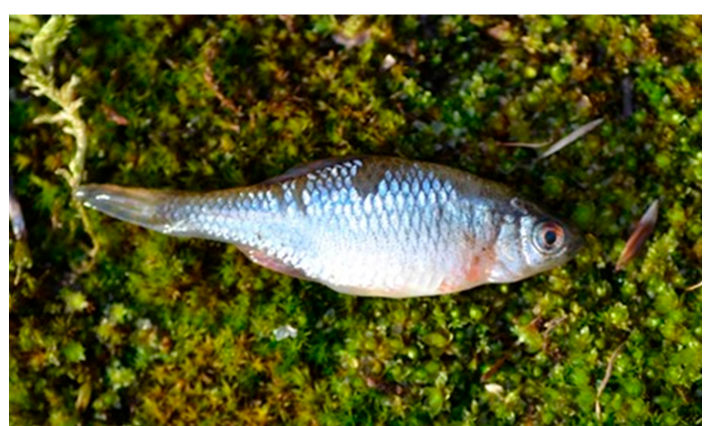
Figure 7. Spined loach caught in Domysławskie Lake (photo: Marcin Biernaczyk).